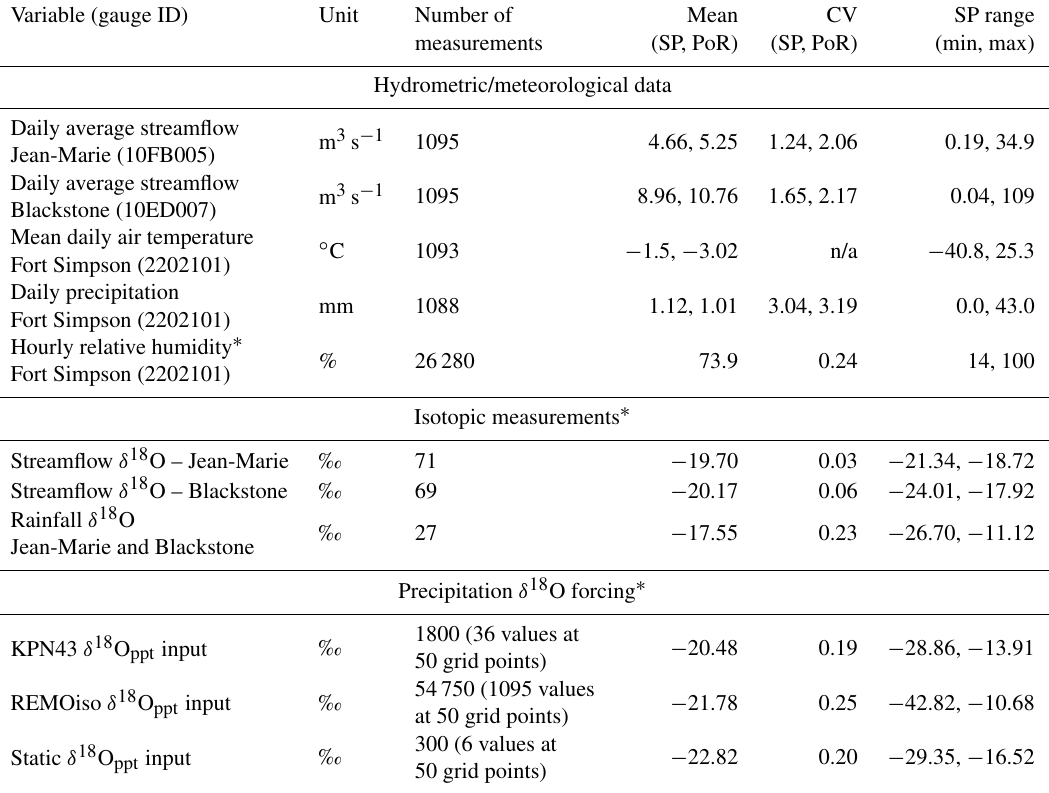
Table 2. Data summary for the study period (SP) and period of record (PoR). The coefficient of variation (CV) is calculated as the ratio of the standard deviation to the